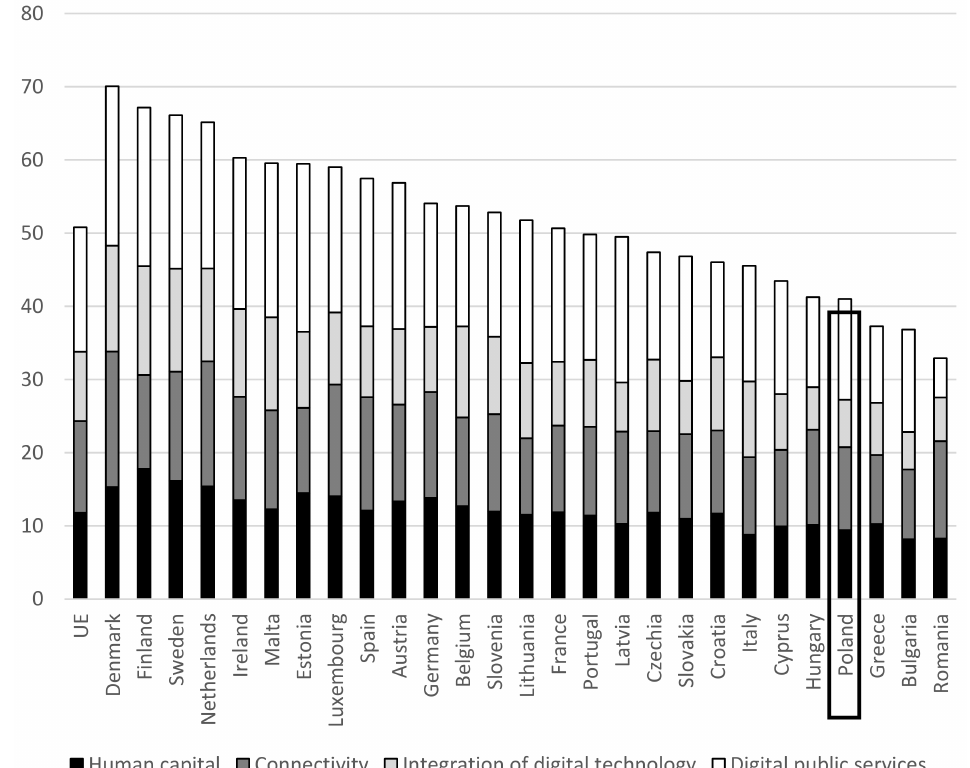
Figure 2. Poland in the ranking of the Digital Economy and Society Index (DESI). Source: Own elaboration based on